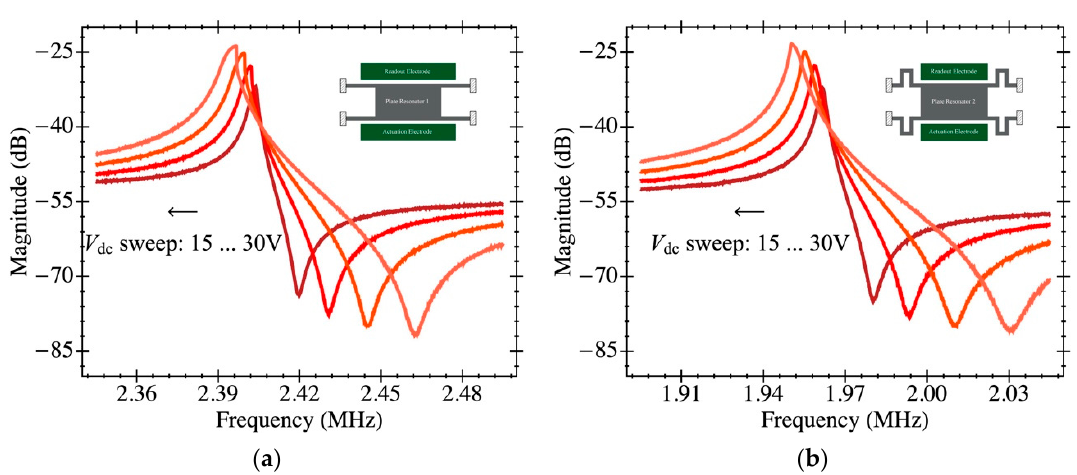
Figure 9. Electromechanical system transmission coefficient measured in open-loop configuration under vacuum pressure ( < 10 − 3 mbar) and 2 dBm input power. The amplifier gain has been reduced by increasing the capacitance at the sensing node to visualize the non-linear behavior previous to amplifier saturation: ( a ) PR1 has a biasing voltage that changes from 15 V to 30 V; ( b ) PR2 has also a sweep in the polarization from 15 V to 30 V.